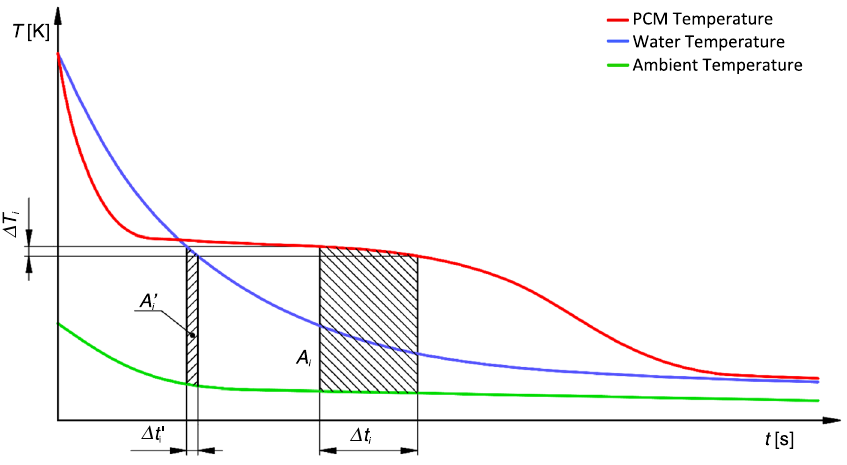
Figure 1. T-history method temperature–time curves (Marín method), demonstration of A i and A ′ i